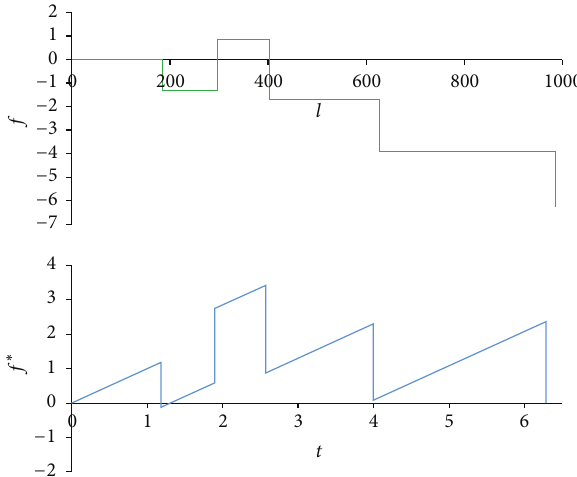
Figure 2: The angle and periodical angle function of the shape from Figure 1.